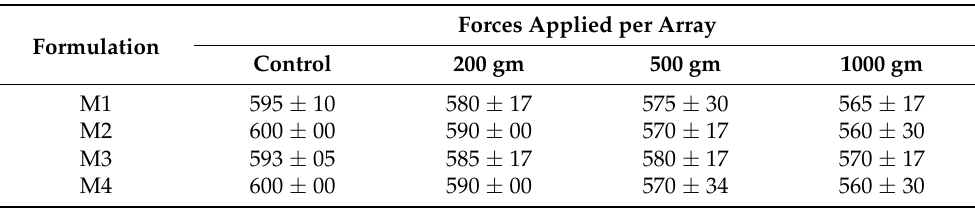
Table 5. The reduction in height (µm) of (M1, M2, M3 and M4 tested as a function of forces of 200, 500 and 1000 g per array (Mean ± SD, n = 3).